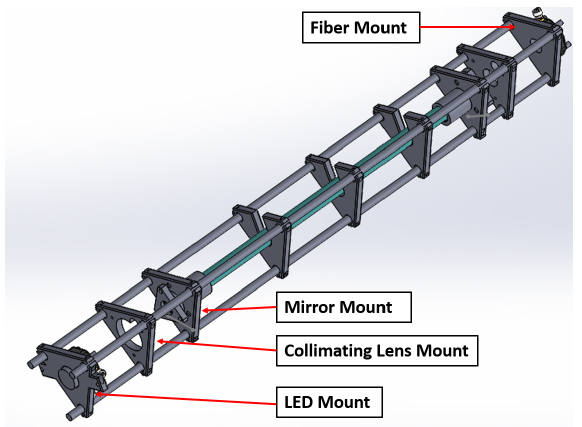
Figure 3. Mechanical drawing of the cage-mounting system for the BBCEAS. Cage plates are con- structed of 3D-printed plastic parts with pultruded carbon tubes forming the optical